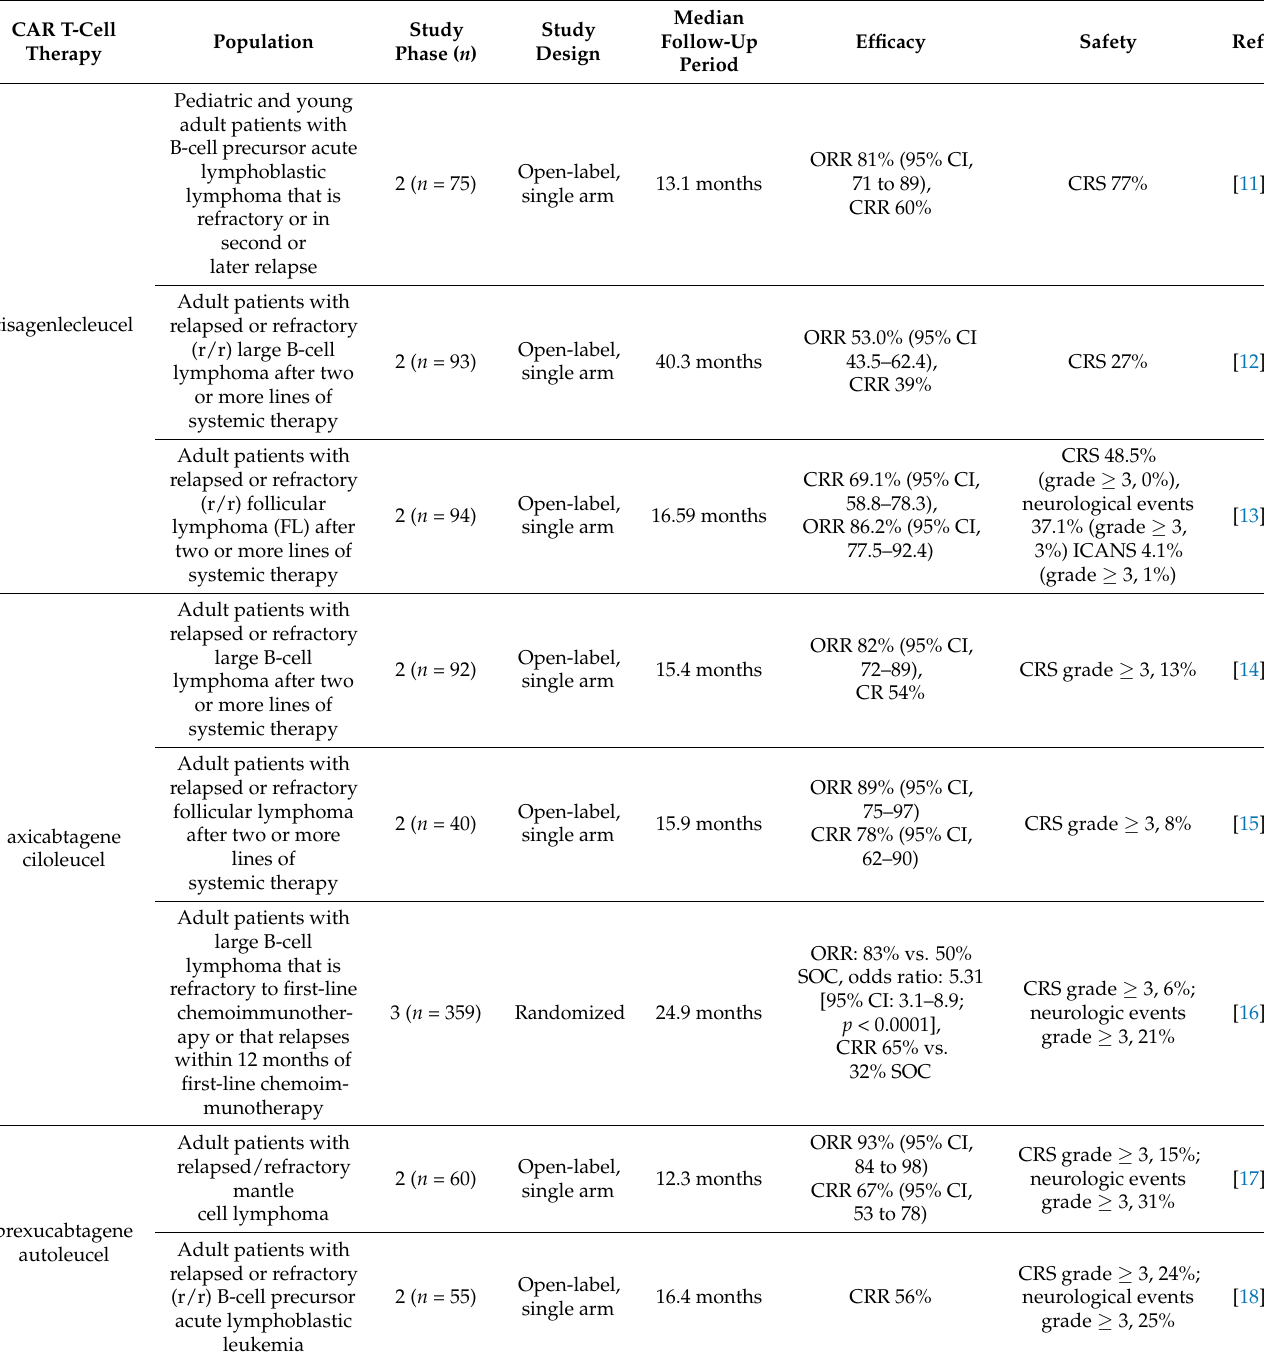
Table 1. CAR T-cell therapies and their clinical trial